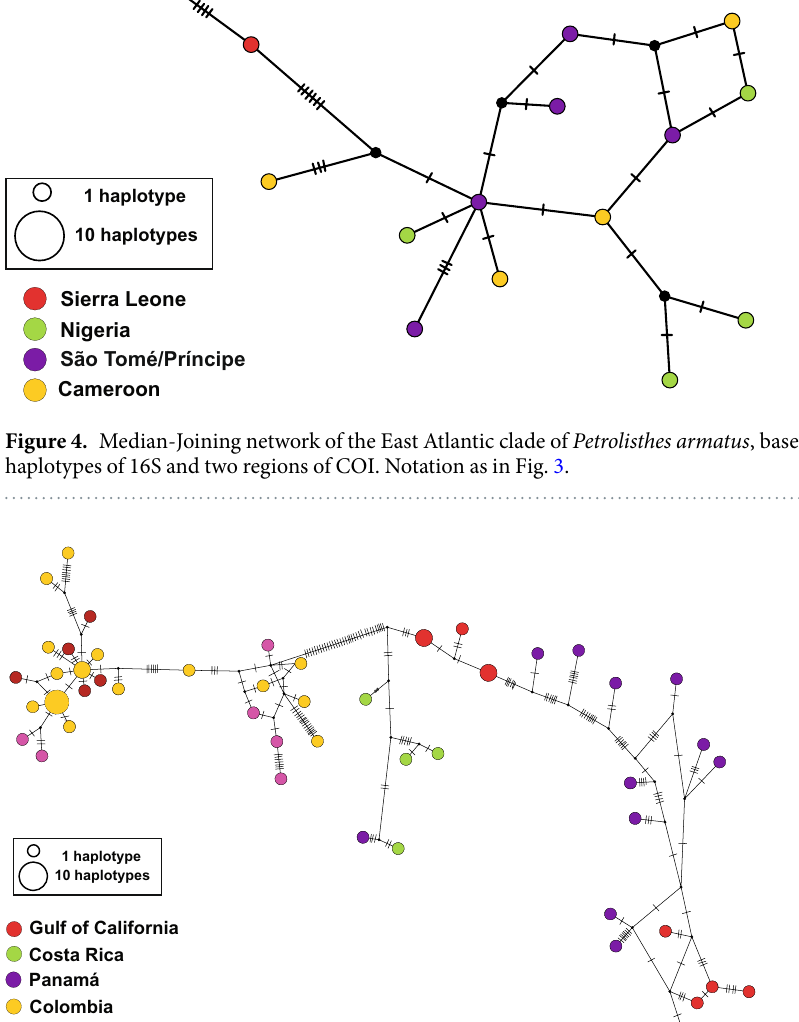
Between regions Between populations Within populations Region % Variation F CT